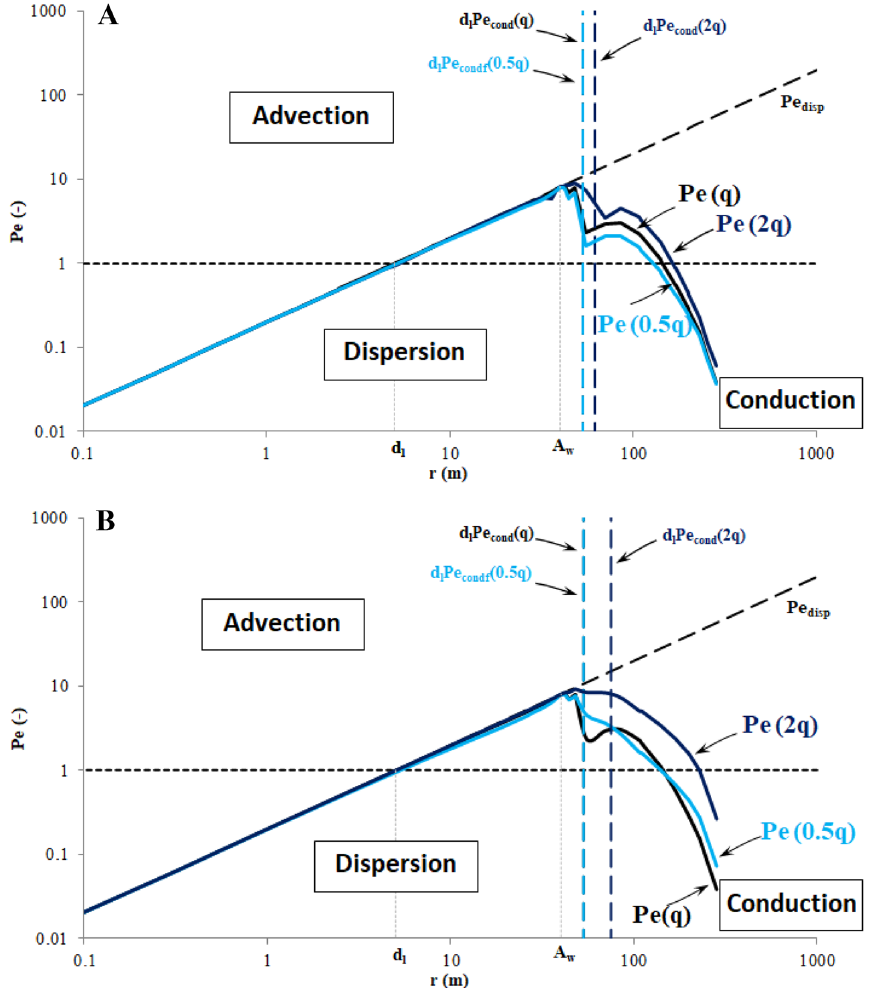
Fig. 16 Simulated Pe in the injection for different intrinsic flow rates of injection (0.5q, q and 2q) during the injection ( A ) and back injection ( B